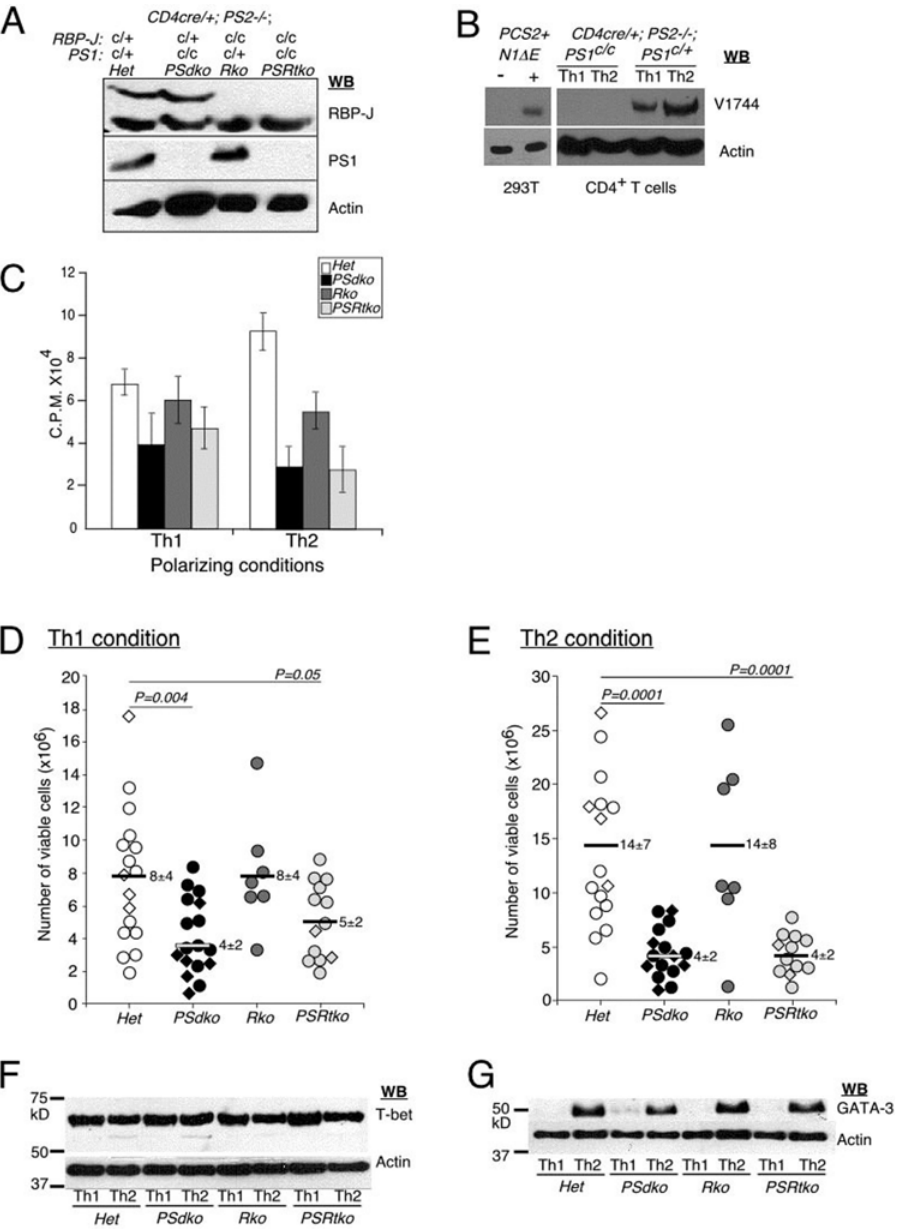
Figure 3. RBP-J independent function of presenilin is required for optimal T cell expansion. (A) Efficient deletion of Presenilin1 and RBP-J alleles by CD4-cre transgene. Naı¨ve CD4 + T cells isolated from conditional knockout littermates (n $ 7 animals per genotype) showed no detectable level of RBP-J and presenilin1 proteins. WB: western blot. (B) Removal of PS1/PS2 proteins abolished Notch1 signaling in activated naı¨ve CD4 + T cells. Activated Notch1 is detected in activated control CD4 + T cells under both Th1 and Th2 polarizing conditions but not detected in T cells that have targeted ablation of PS1/PS2 alleles. Non transfected HEK293T cells were used as negative control, while cells transfected with PCS2 + N1 D E was used as a positive control. CD4 + T cells were isolated with anti-CD4 magnetic beads on MACS column to . 95% purity from the spleens of 2 months old littermates. This protocol allows co-purification of natural APCs that provide the Notch ligands (compare with Figure 2C where no Notch1 activation was observed when a two-step purification method was used). T cells were activated with anti-CD3/CD28 in Th1 or Th2 polarizing conditions for 24 h. T cells were then FACS sorted for CD4 + population and probed with V1744 antibody. WB: western blot. (C) Proliferation capacity was measured by 3 [H]-thymidine incorporation. Reduced proliferation was observed in PSdko and PSRtko cells under both Th1 and Th2 polarizing conditions. Rko cells were not significantly different than controls. Results are presented as mean 6 S.D. of five wells and representative of at least three independent experiments. (D, E) Reduction in the final number of viable PSdko and PSRtko T cells 6 days after activation. Naı¨ve CD4 + T cells from different genotypes were stimulated with anti-CD3/CD28 antibodies for 2 days in Th1 and Th2 conditions before they were expanded in fresh media containing IL-2 cytokine. After 6 days of culture, T cells were harvested and viable cells were counted. Each circle/diamond indicates data of individual mouse. In Figures 1–4, circle ( # ) indicates data point in which CD4 + T cells were expanded by regimen 2 (Supplemental Table 4B), whereas diamond ( e ) indicates result in which T cells were expanded according to regimen 3 (Supplemental Table 4C). The P value was determined by student two- tailed t test. (F, G) The expression of T-bet and GATA-3 is unaffected by the removal of RBP-J and/or presenilins. T cells activated in Th1 or Th2 conditions were harvested and probed with T-bet or GATA-3 antibodies after 6 days in culture. Results are representative of three independent experiments. WB: western blot.